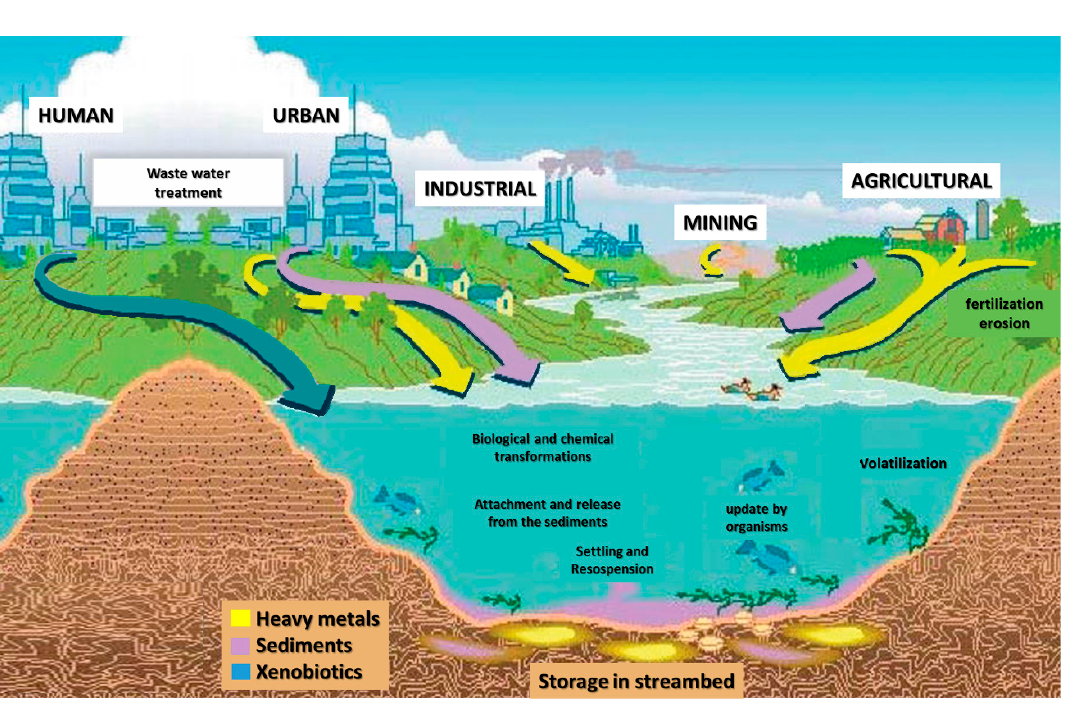
Figure 1. Connections and sources of xenobiotics that are poured into the environment as result of human activities.